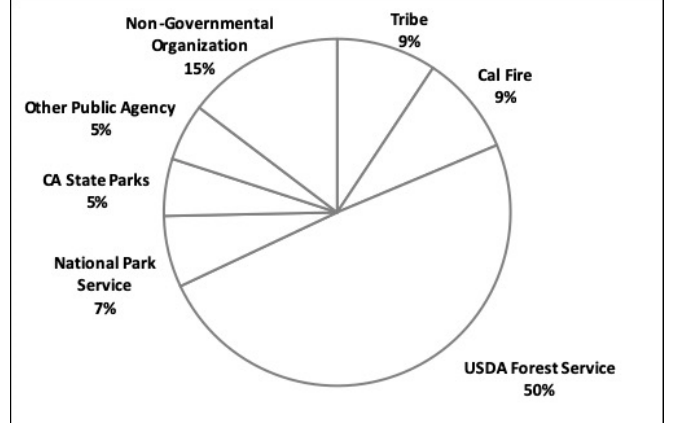
Figure 1. Affiliation of Fire Managers Who Participated in Surveys and Interviews. A total of 75 fire managers participated from 2016–2019.